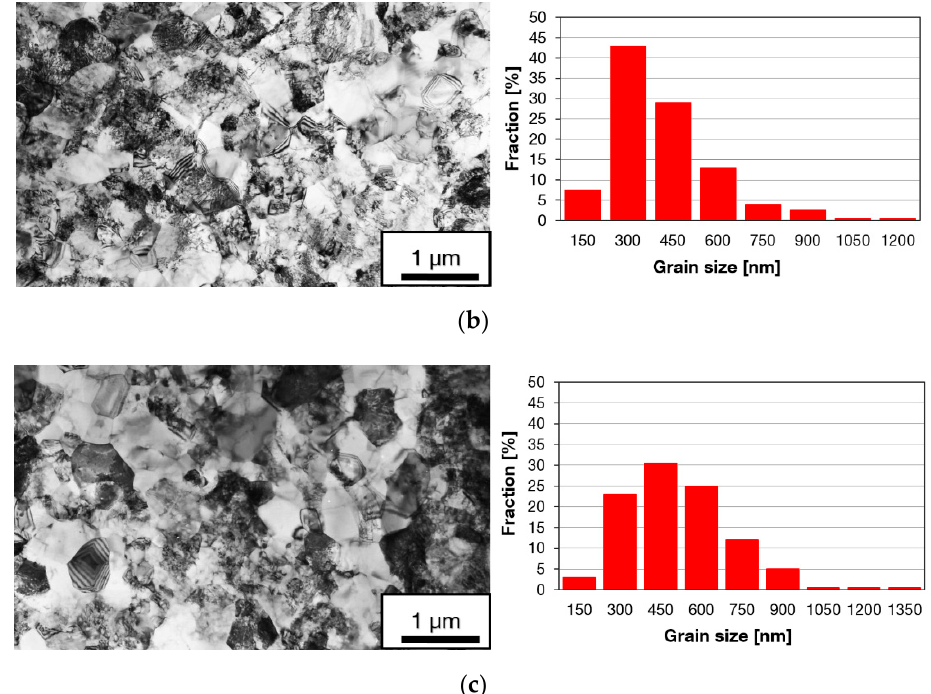
Figure 4. Substructures and grain size histograms in the transverse direction: ( a ) After the first pass; ( b ) after the second pass; ( c ) after the third pass through the Conform SPD machine.